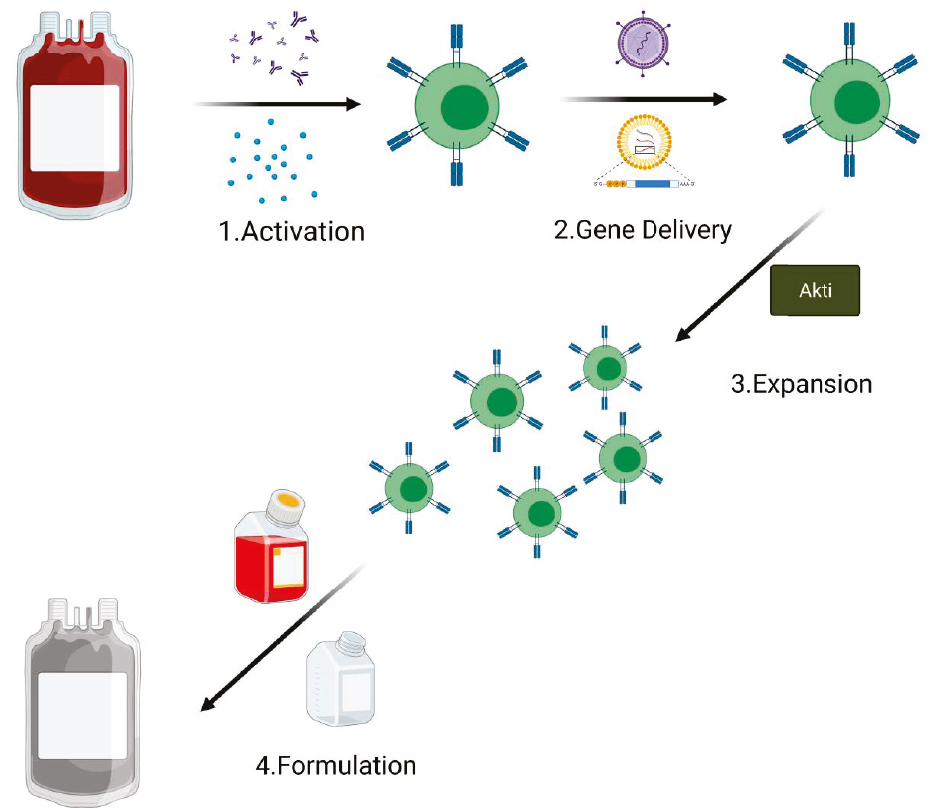
Figure 4. PI3K/Akt inactivation during the CAR T cell manufacturing process. The addition of Akti in the expansion phase sustains amplification of transduced T cells. The addition of Akti during CAR T cell expansion in the manufacturing process improves its expansion and efficacy (Created with BioRender.com: agreement number PT22NUG36Q). Different isoform selective PI3K inhibitors have been developed to treat diseases. To date, five of them are approved by the FDA and/or EMA agencies either as a single agent or in combination for the treatment of different malignancies. With the exception of the selective PI3K alpha inhibitor alpelisib, approved in combination with fulvestran for HR- positive and HER2/neu-negative breast cancer therapy [73], the other four remaining drugs are indicated for various hematological malignancies. Idelalisib, a specific PI3K δ inhibitor, in combination with an anti-CD20 antibody, rituximab [74], as well as duvelisib, a dual PI3K δ / γ selective inhibitor [75], are both approved for the treatment of relapsed or refractory CLL and small lymphocytic and follicular lymphomas. Copanlisib, which targets the PI3K α / δ isoforms, is indicated for patients affected by follicular lymphoma [76], and umbralisib, a dual PI3K δ and casein kinase 1 inhibitor, was recently approved for patients affected by relapsed or refractory marginal zone lymphoma who previously received and anti-CD20 therapy and relapsed and refractory follicular lymphoma [77]. Other compounds have either entered early clinical stages or received a fast-track designation with the FDA. For instance, the Pan-PI3K inhibitor buparlisib entered into a phase 3 clinical trial for head and neck cancer patients who received a prior treatment with anti-PD1 therapy (NCT04338399; see Table 1). Zandelisib, a selective PI3K δ inhibitor,